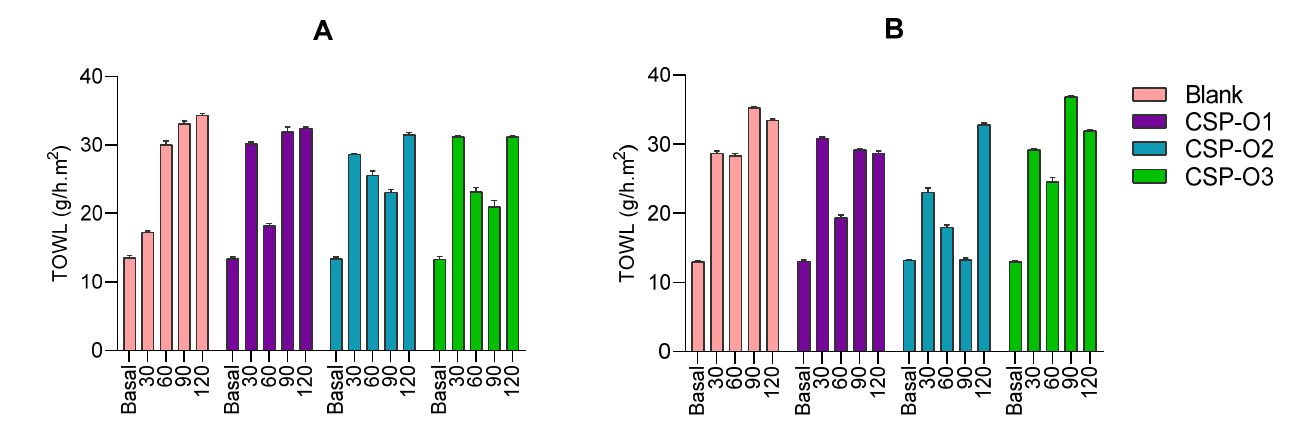
Figure 5. TOWL obtained after a two-hour application of the samples to ( A ) the corneal membrane and ( B ) the scleral membrane. Each value represents the mean ± SD ( n = 10). All formulations at all times, with the exception of basal, show statistically significant differences ( p < 0.001).